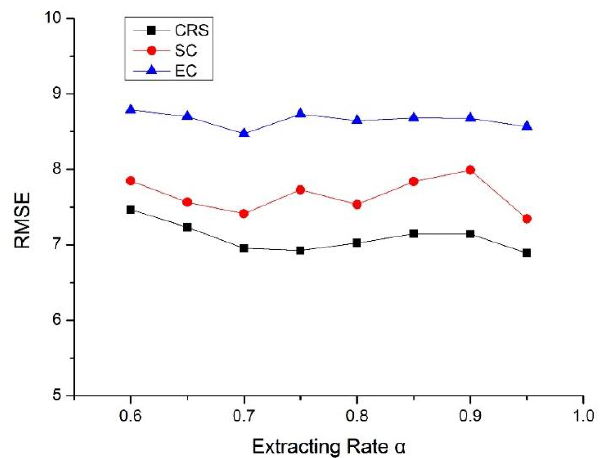
Figure 11. Comparison between critical road sections (CRS) case, stochastic case (SC) and extreme case (EC).